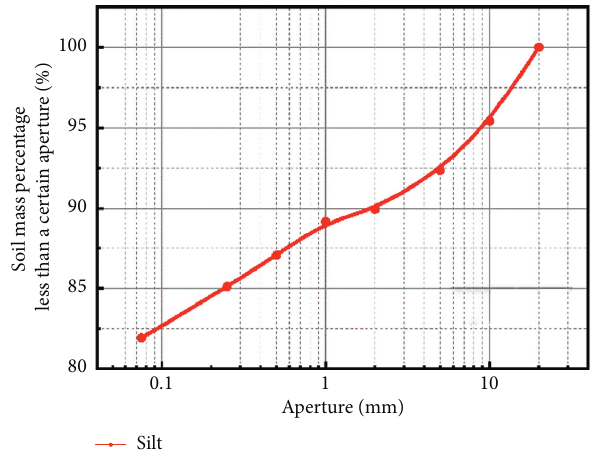
Figure 1: Grading curve of soil samples.